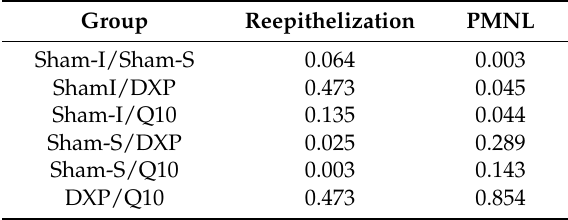
Table 7. The post hoc test results of the histopathological grading score values. The Mann-Whitney